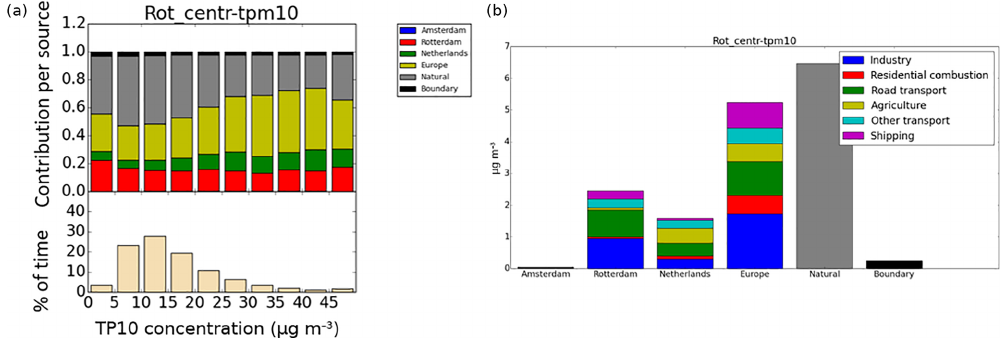
Figure 7. Source apportionment for Rotterdam city centre, 2011. Relative contribution of several source sectors to daily average PM 10 concentrations (a) and annual-average absolute contributions of PM 10 from several source regions and sectors (b) . Note that the natural and boundary contributions have by construction no contributions of sectors or countries.